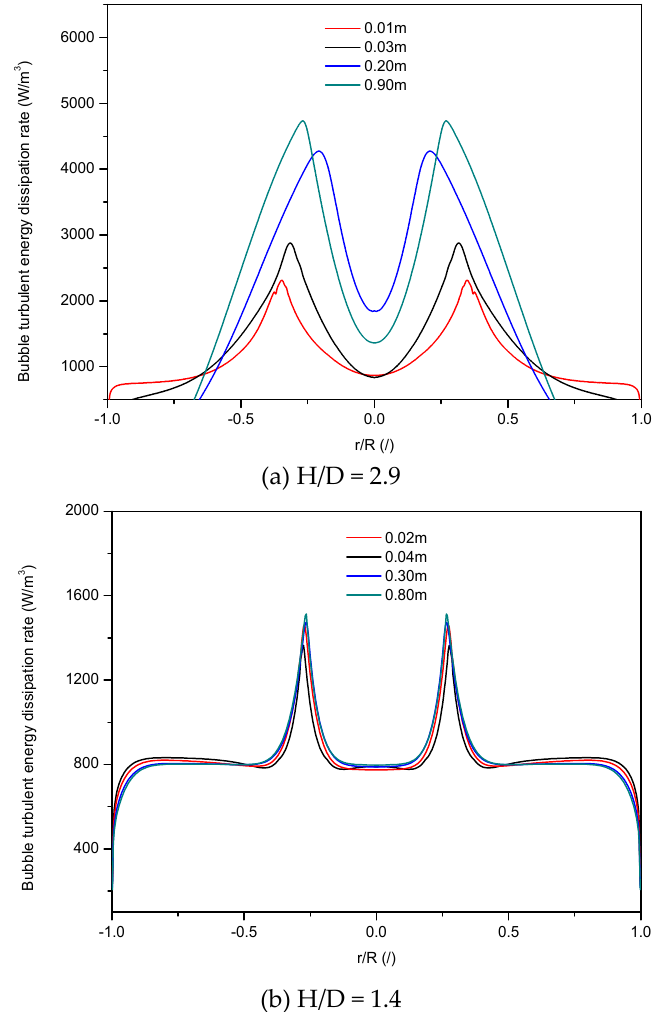
Figure 7. Distributions of turbulent energy dissipation rate of bubble phases using two jetting holes (rjet/R = ±0.36), H/D = 2.9 and H/D = 1.4.